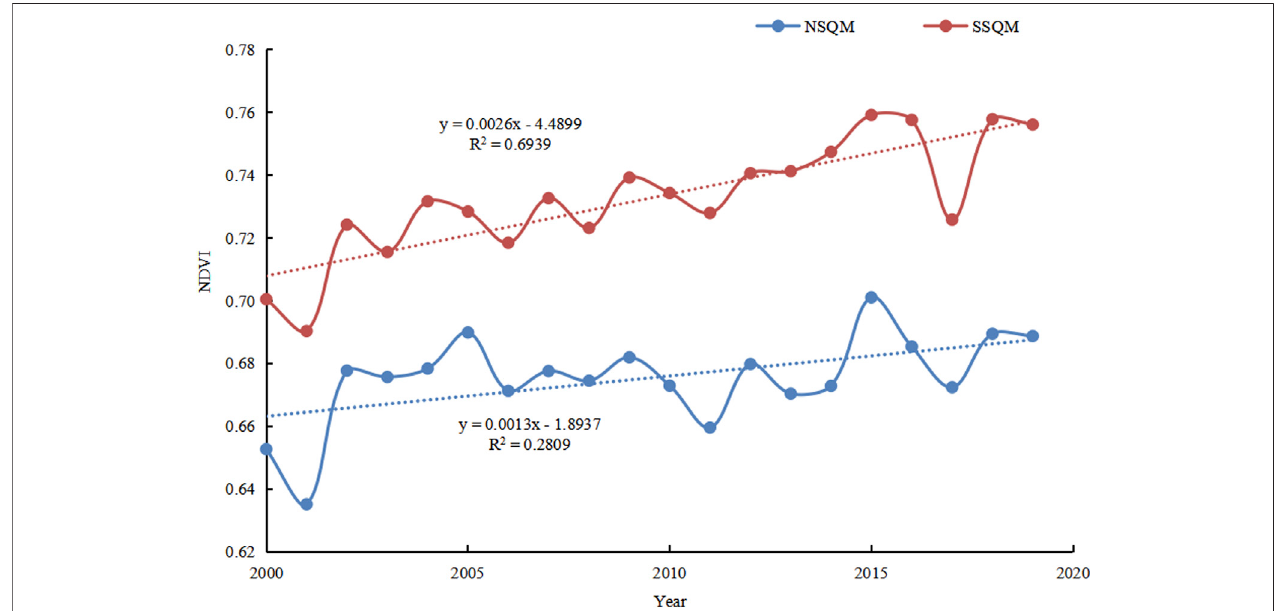
FIGURE 2 | Interannual variation of growing season normalized difference vegetation index (NDVI) in the northern and southern slopes of the Qinling Mountains (NSQM and SSQM) during 2000 – 2019.